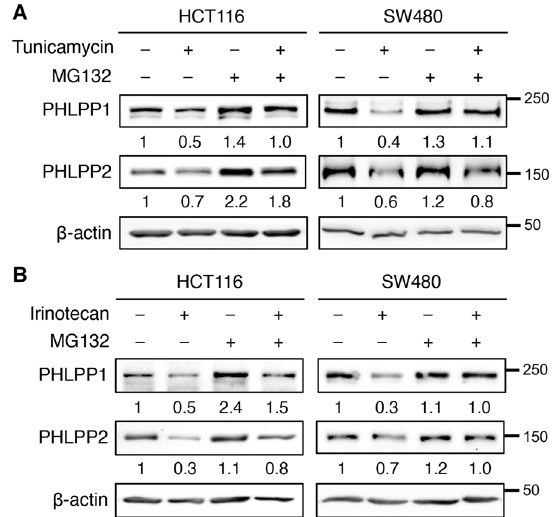
Fig. 3 Inhibition of proteasome attenuates ER stress-induced PHLPP degradation in colon cancer cells. a HCT116 and SW480 cells were treated with tunicamycin for 24 h and MG-132 (10 μ M) was added during the last 8 h of the treatment. The expression of PHLPP1, PHLPP2, and β -actin was analyzed using Western blot. The relative expression levels of PHLPP1 and PHLPP2 were obtained by normalizing to β -actin. b HCT116 and SW480 cells were treated with irinotecan for 24 h and MG-132 was added during the last 8 h of the treatment. The expression of PHLPP1, PHLPP2, and β -actin was analyzed using Western blot. The relative expression levels of PHLPP1 and PHLPP2 were obtained by normalizing to β